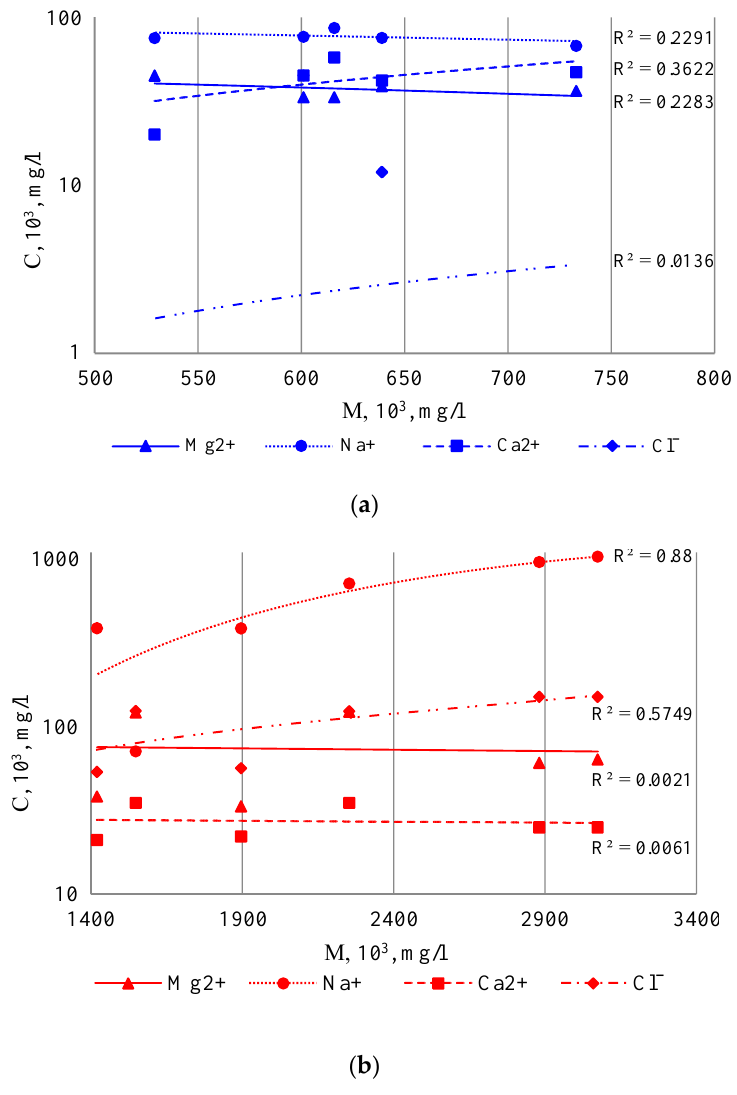
Figure 9. Correlation between mineralization (M) and concentration of macrocomponents (Na, Mg, Ca, and Cl) in lake water of Burabay rock mass: ( a )—fresh water; and ( b )—salty